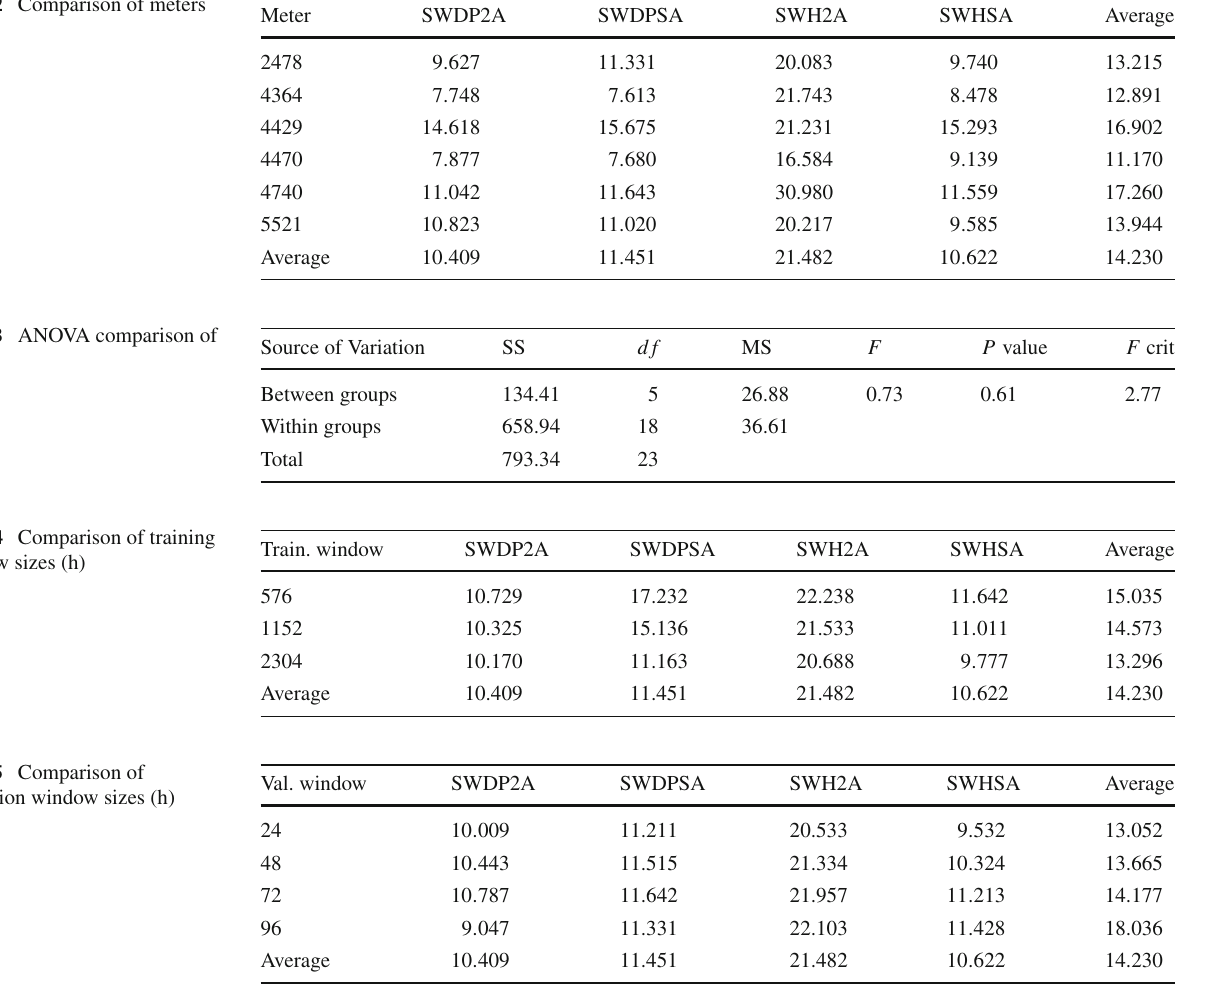
Table 2 Comparison of meters (h)